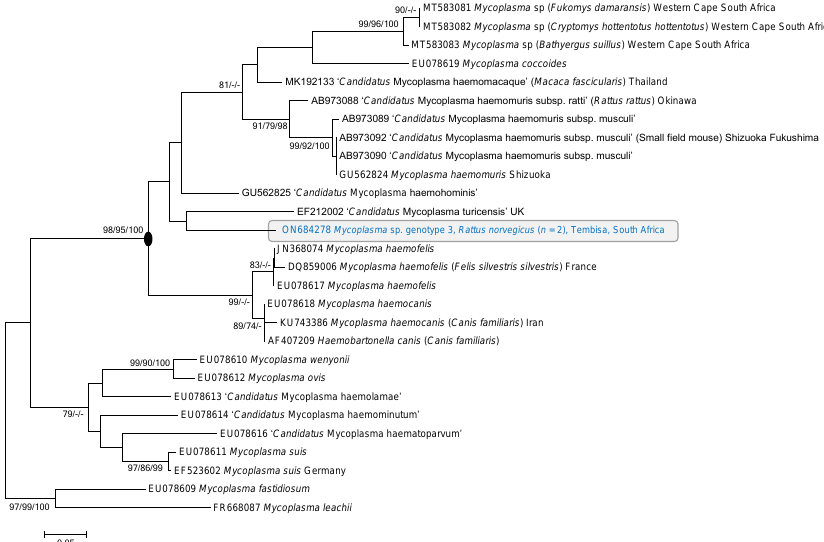
Figure 4. Minimum evolution tree depicting genetic relationships of a Rattus -associated hemoplasma genotype, indicated in blue, detected in a R. norvegicus sampled in the Gauteng Province of South Africa, with relevant reference sequences. Genbank accession numbers of the three haemoplasmas detected in the current study are indicated. This haemoplasma genotype fell within the Haemofelis cluster (circled at the node), but close phylogenetic relationships could not be resolved. The tree was inferred using the aligned 225 nucleotide data set of the Rnase P gene region. Bootstrap support values ≥ 70% from the minimum evolution analysis (ME; 10,000 bootstrap replicates), maximum likelihood (ML; 10,000 bootstrap replicates); posterior probability support values ≥ 90% from the Bayesian inference (BI; 1,000,000 generations sampled every 10 generations with a 25% burn-in) are indicated as ME/ML/BI next to each